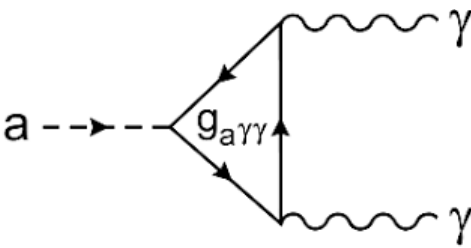
Figure 2. Feynman diagram of photon-axion coupling